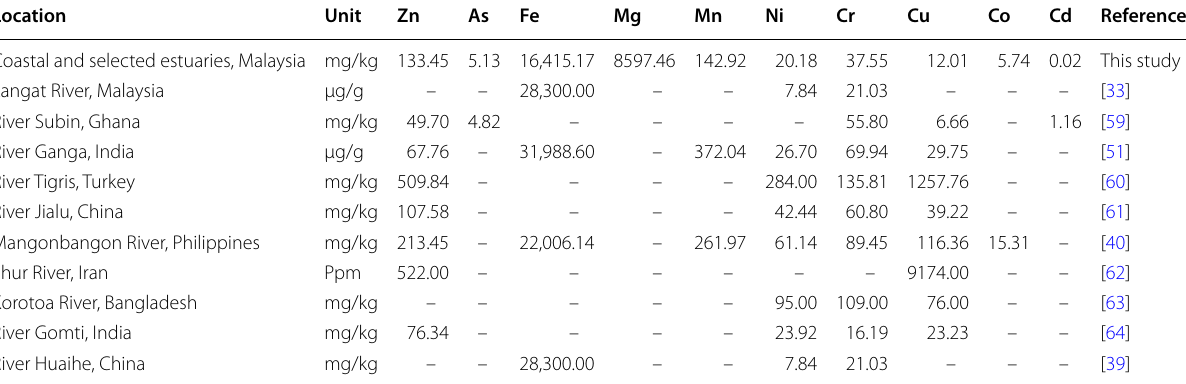
Table 7 Detected trace metal concentrations in surface sediments in the study sites and in some selected world rivers